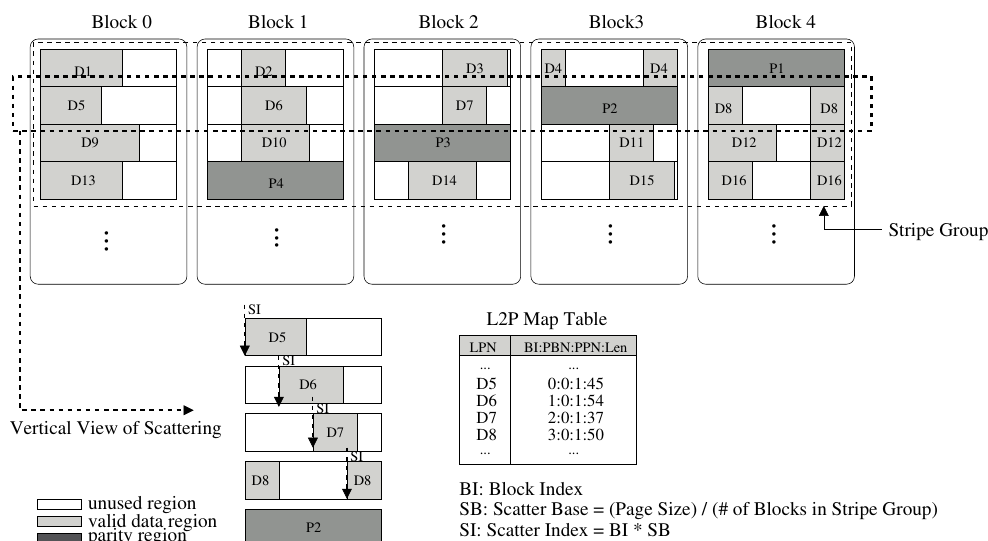
Figure 4. Compression-assisted RAID scattering